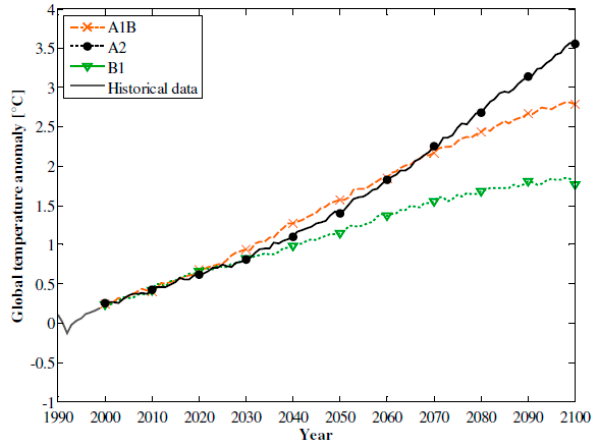
ff erent Greenhouse Gas (GHG) emissions scenarios Figure 2. Yearly mean temperatures for different Greenhouse Gas (GHG) emissions scenarios [22]. Figure 2. Yearly mean temperatures for di